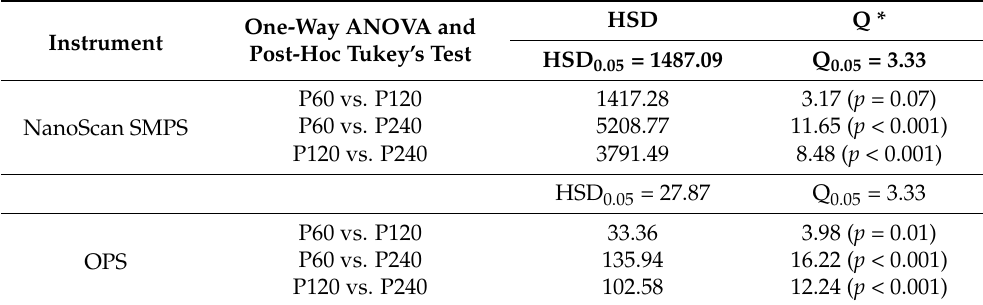
Table 2. One-way ANOVA and post-hoc Tukey’s test results comparing sanding paper grit by particle number